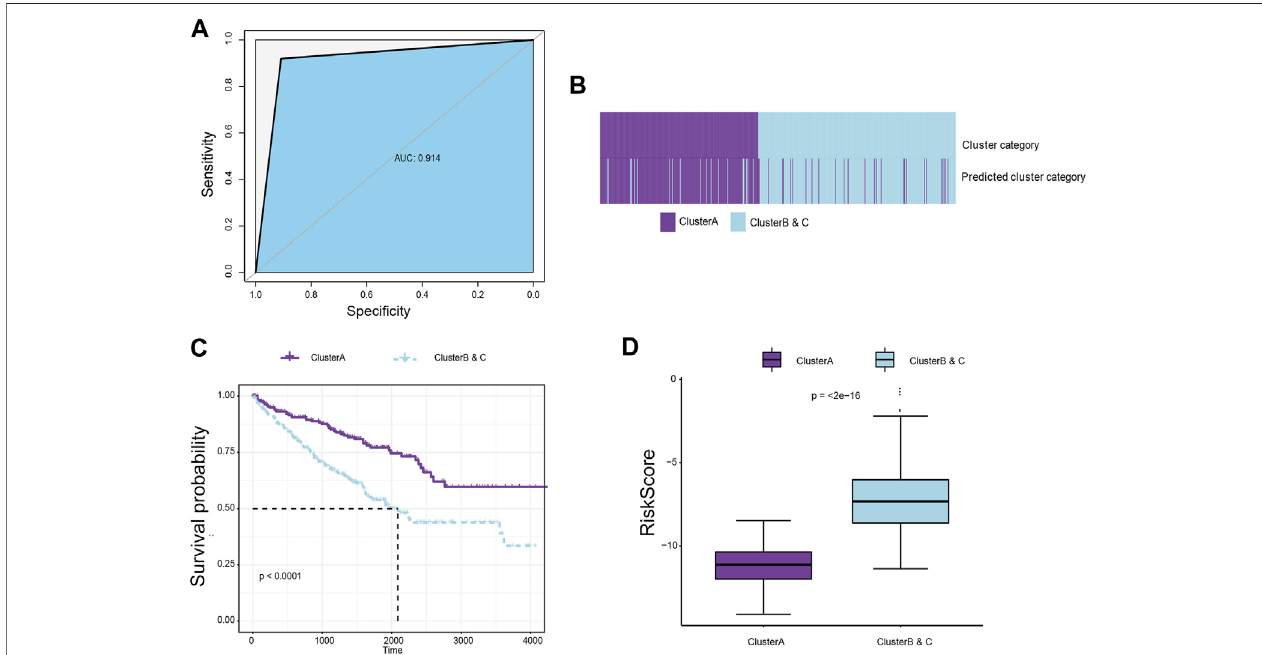
FIGURE 4 | Construction of a classi fi er to predict immune subgroups using machine-learning algorithms. (A) Machine-learning algorithms were used to develop a simple predictor to predict immune clusters, thereby randomly assigning all samples to the group with poor or good prognosis until the best prediction ef fi ciency is obtained. A total of 26 hub immune genes were identi fi ed for the prognostic predictor for subgroup classi fi cation. (B) For the training set samples, immunophenotyping clusteringwasusedtodeterminewhetherthesamplesbelongedtoClusterAorClustersBandC. (C) .Survivaldifferencebetweenimmunophenotypingclustersof ccRCC patients in the training cohort. (D) The logistic regression coef fi cient was further used to calculate the risk score of each sample.